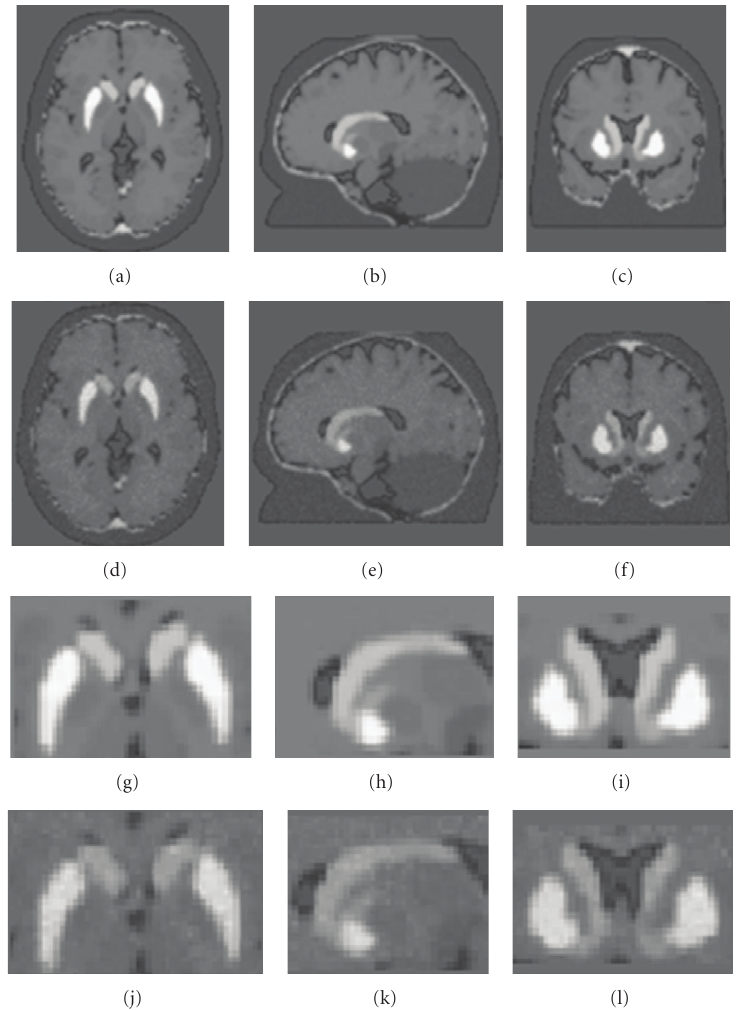
Figure 3: HRRT phantom. (a), (b), and (c) represent the transaxial, sagittal, and coronal views of the HRRT phantom with the ideal noise level, while (d), (e), and (f) represent to the same phantom with the more realistic noise level. Figures 3(g) to 3(l) are the zoomed (400%) to the striata in the images presented in (a) to